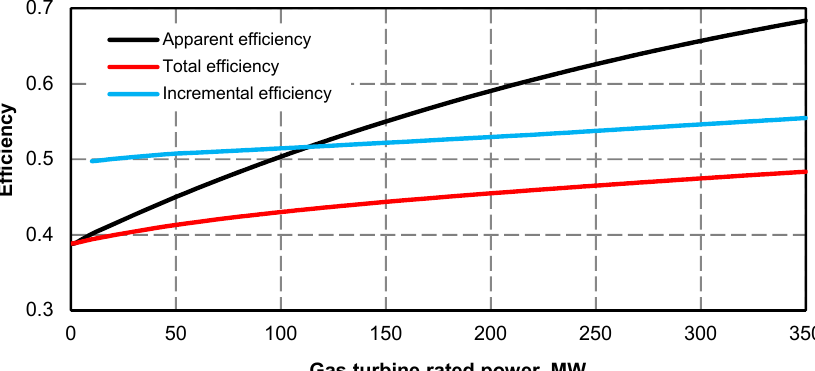
Figure 34. The energy efficiency for the power unit with superstructure added as a function of gas Figure 33. The energy efficiency for the power unit with superstructure added as a function of gas turbine rated power at a minimum steam boiler output of 133.3 kg/s and with gas turbine operating Figure 33. The energy e ffi ciency for the power unit with superstructure added as a function of gas Figure 33. The energy efficiency for the power unit with superstructure added as a function of gas turbine rated power for a maximum fixed stream of 319.4 kg/s fresh steam fed to the steam turbine. at its rated power. turbine rated power for a maximum fixed stream of 319.4 kg / s fresh steam fed to the steam turbine. turbine rated power for a maximum fixed stream of 319.4 kg/s fresh steam fed to the steam turbine.